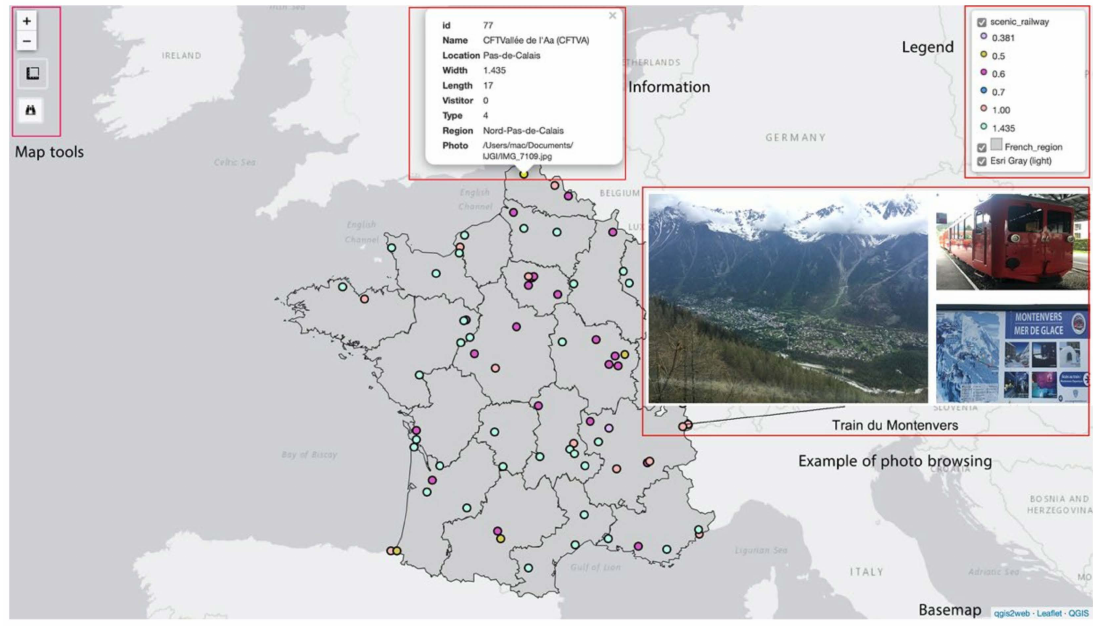
Figure 8. The output webpage of the scenic